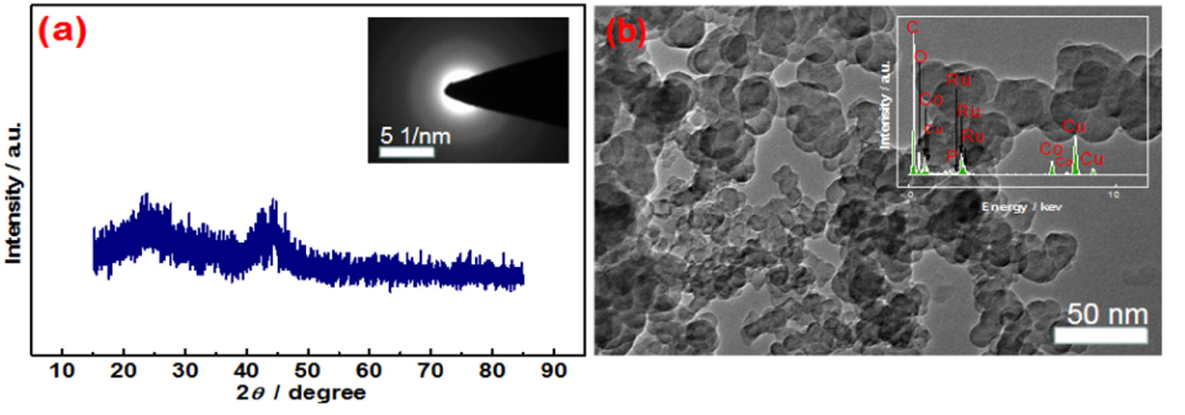
Figure 3. XRD patterns ( a ), TEM images ( b ) of RuCoP/C; insert: SAED pattern ( a ), and EDX ( b ). To confirm the above point, RuCoP/C was treated at 200, 300, and 400 ◦ C, leading